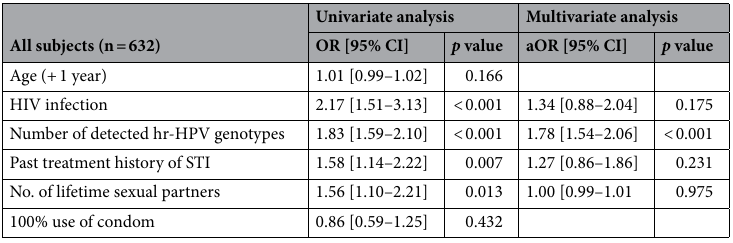
Table 3. Multiple logistic regression analysis to determine factors associated with abnormal anal